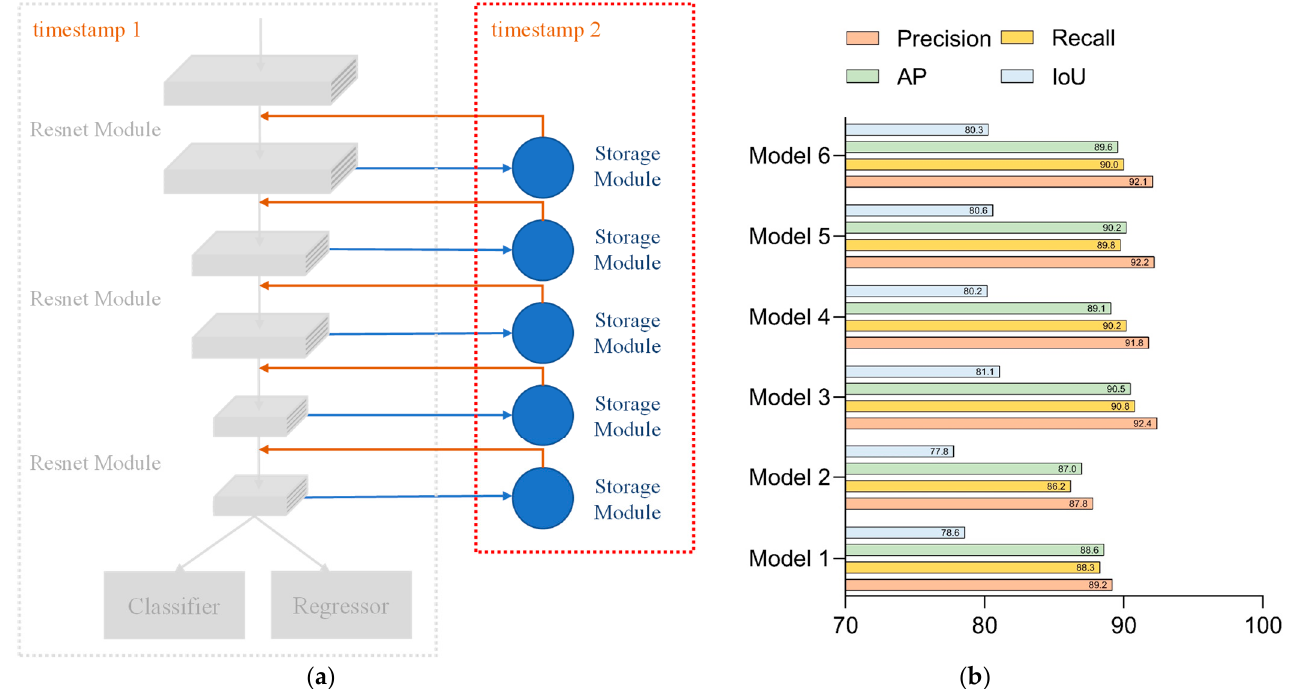
Figure 9. Network 2: ( a ) configuration of Network 2 and ( b ) test results for each parameter of Network 2.